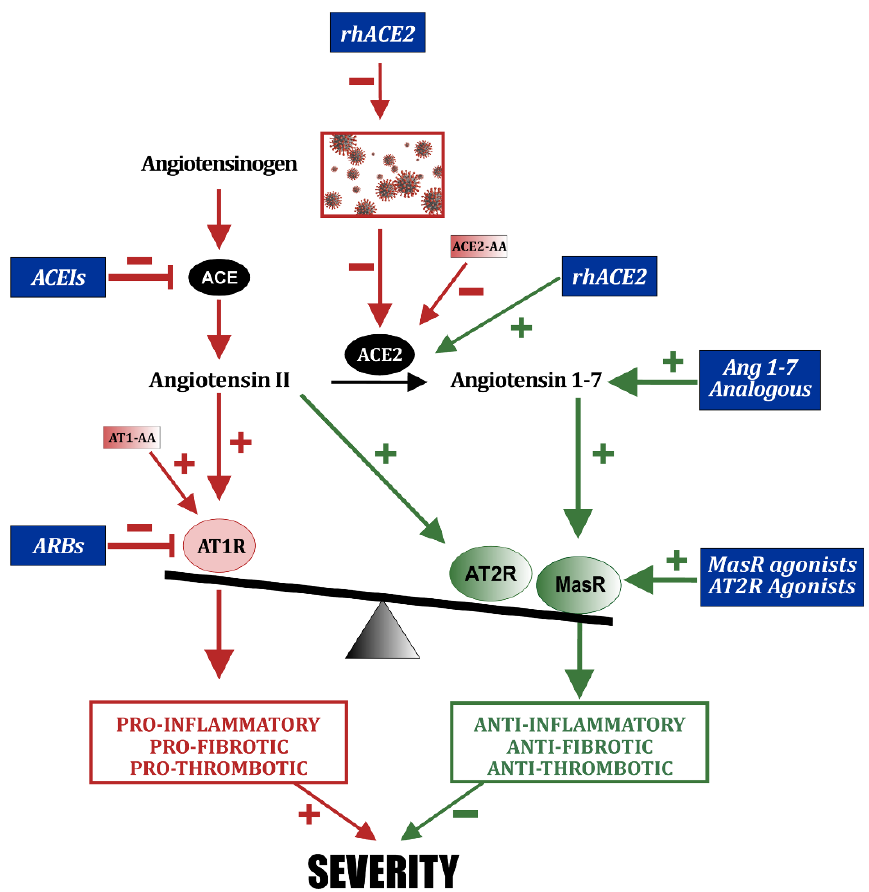
Figure 3. Current therapeutical strategies with drugs that inhibit components of the RAS pro-inflammatory axis or enhance components of the RAS anti-inflammatory axis.